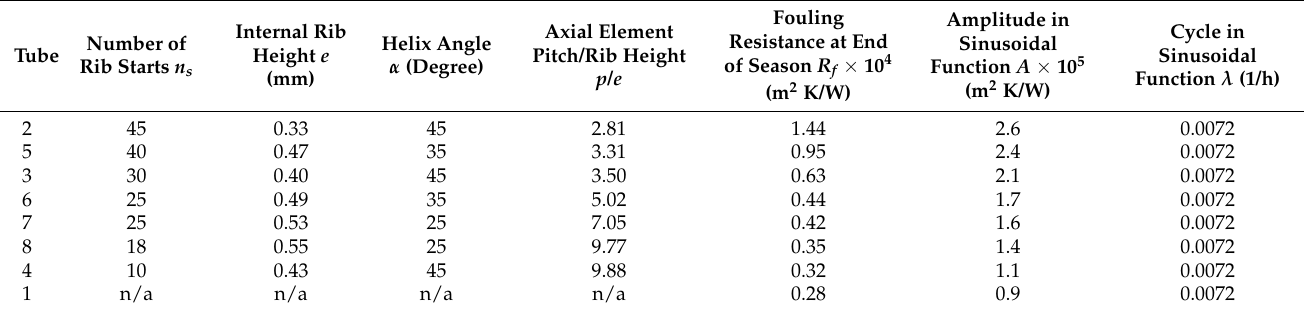
Table 2. Internal geometric parameters of the eight tested tubes (inside tube diameter = 15.54 mm; included angle between sides of ribs = 41 deg; fin tip thickness = 0.024